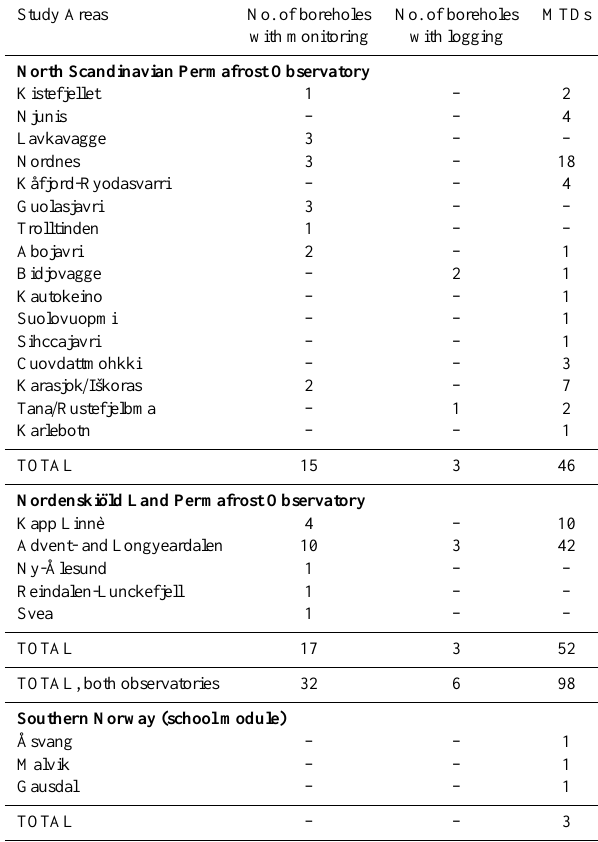
Table 1. All NORPERM study areas in the North Scandinavian and Nordenski¨old Land Permafrost Observatories, including the num- ber of boreholes and miniature temperature data-loggers (MTDs). with manual temperature logging are listed